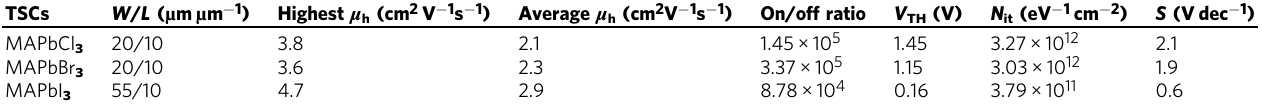
Table 2 The fi gures of merit of BGBC TSC-FET devices based on MAPbX 3 (X = Cl, Br, and I) TSCs W / L ( µ m µ m − 1